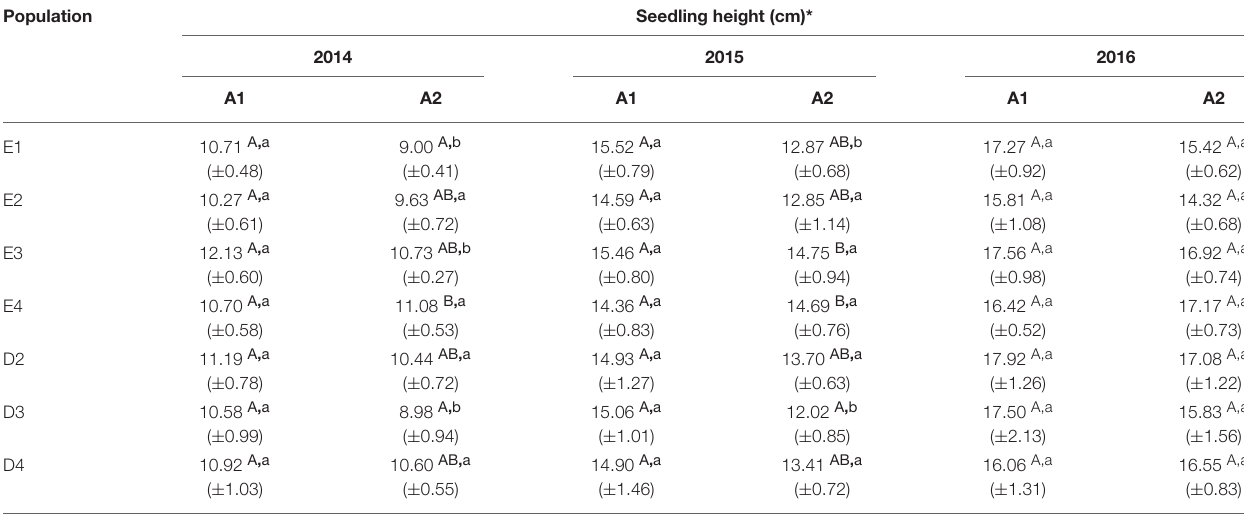
TABLE 4 | Total seedling height at the end of each growth period under irrigation schemes A1 and A2 (Mean values ± SE).